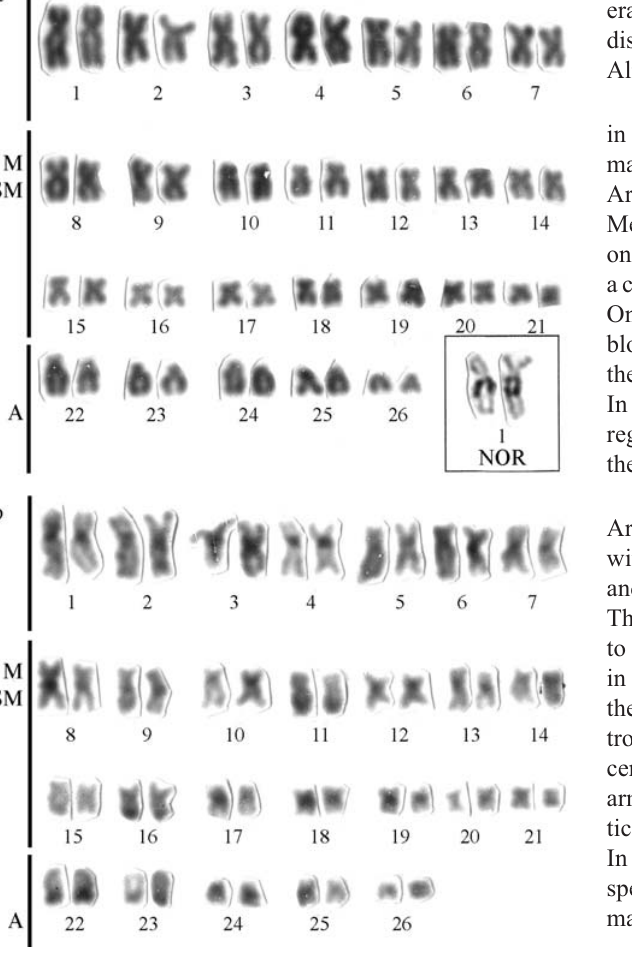
Figure 2 - Karyotype of Electrophorus electricus from the Araguaia River. a) Giemsa stained chromosomes; b) C-banded karyotype. In the in- sert, silver-stained